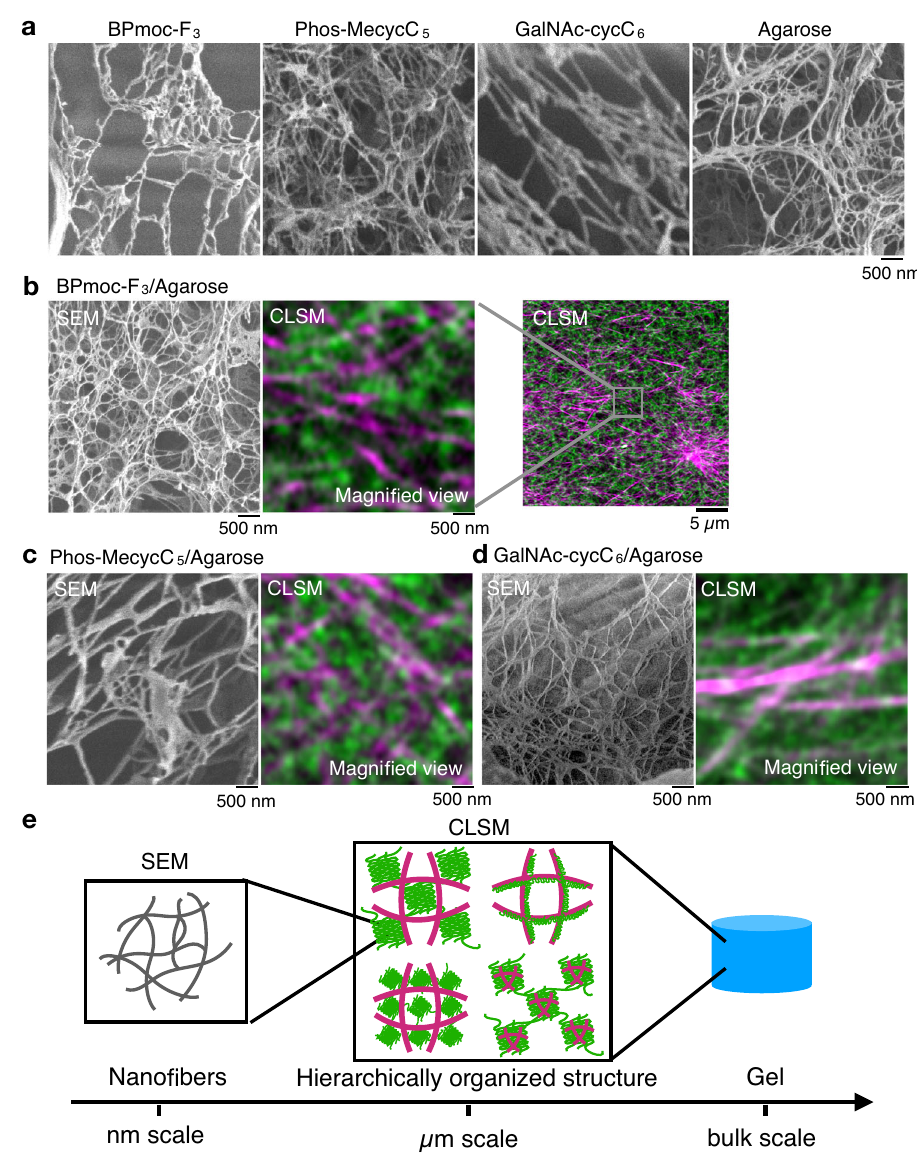
Fig. 3|Hierarchicalstructuresrevealedbymultiscaleimaging.a SEMimagesof single-component hydrogels. b (Left) SEM images and (middle and right) CLSM images of BPmoc-F 3 /agarose.The middlewasa magni fi edimage of the rightCLSM image (the same as Fig. 2b). c , d (Left) SEM images and (right) CLSM images of c Phos-MecycC 5 /agarose and d GalNAc-cycC 6 /agarose. Magenta: supramolecular